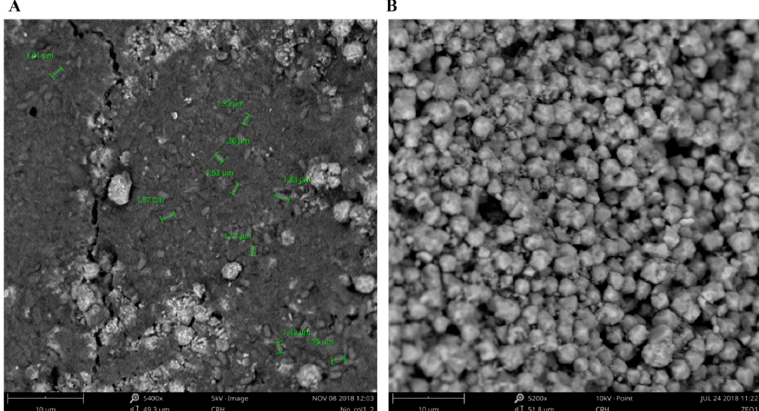
Figure 10. Zeolite covered with biofilm ( A ) and zeolite without biofilm ( B ). Images obtained from SEM.